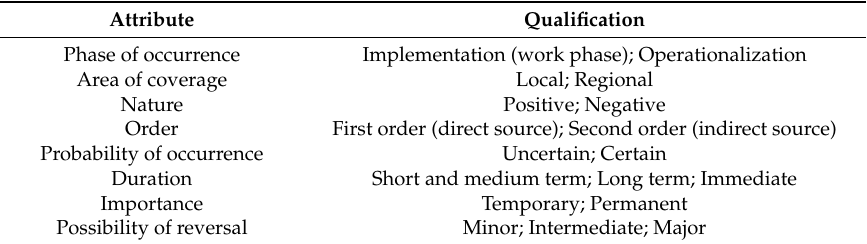
Table 3. Environmental impact attributes pertaining to noise emissions and immissions.